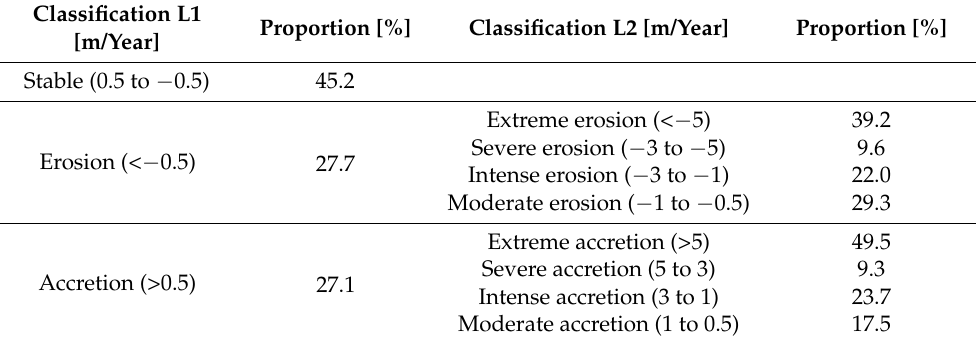
Table 3. Proportion of coastline change classes in